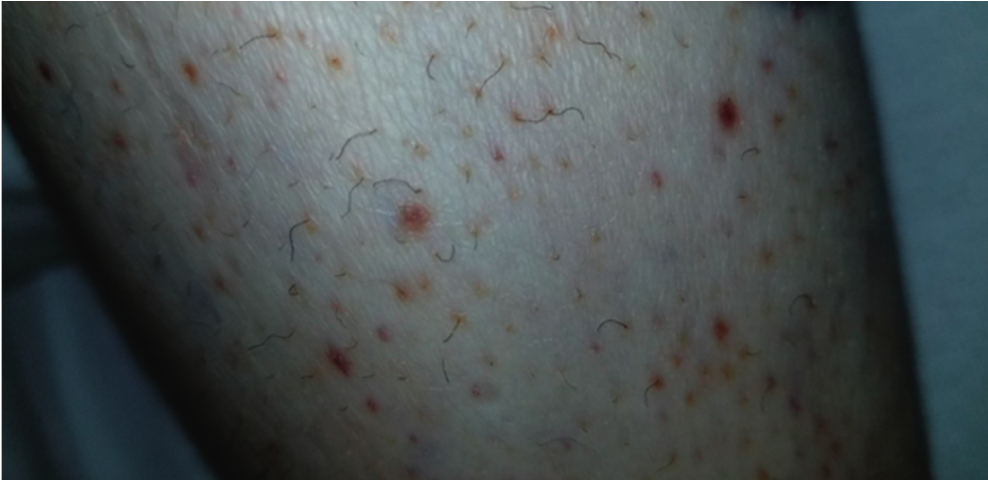
Figure 2: Corkscrew hair and perifollicular petechiae which are commonly seen in